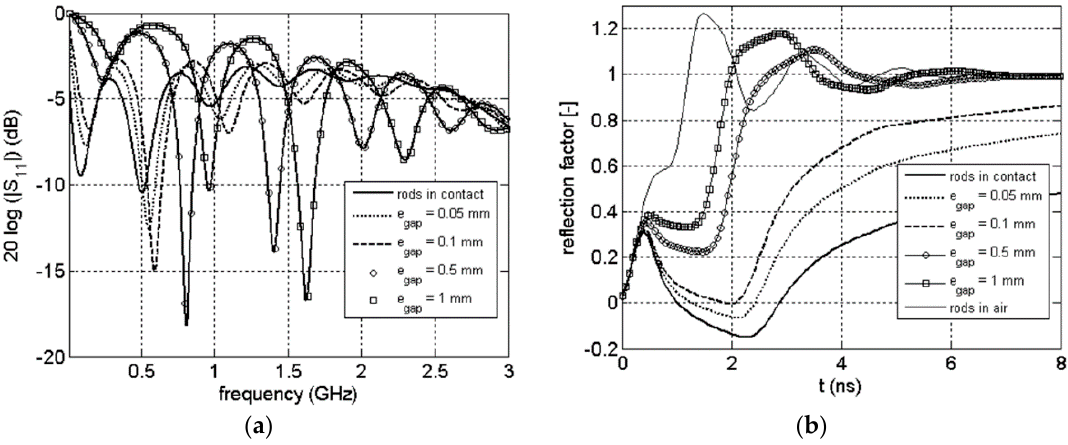
Figure 9. Magnitude of scattering function S 11 ( ω ) ( a ), corresponding TDR waveform ( b ) for the probe surrounded by air and clay rock ( θ = 0.066 m 3 /m 3 ).